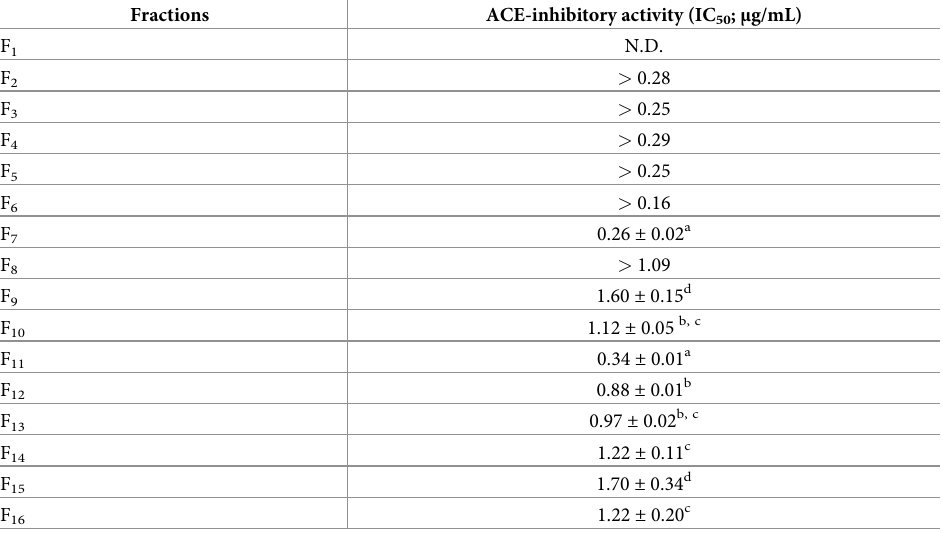
Table 6. ACE-inhibitory activity for each of the sixteen fractions obtained via RP-HPLC in terms of the IC 50 value ( μ g/mL).